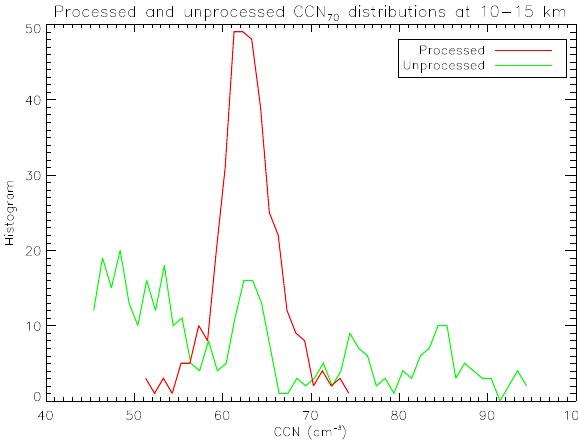
Fig. 5. Time series of surface-level N 10 . In both parts of each plot, the solid horizontal line shows the mean of all 360 measurements. Blue diamonds represent unperturbed values, and red diamonds rep- resent perturbed values. (a) The dashed horizontal lines show the uncertainty on the mean, as given in Eq. (7). The diamonds show the daily means, and the error bars show the 95% confidence in- terval of the distribution between the months on that day, as given in Eq. (6). The ensemble mean is always within the 95% CI for both perturbed and unperturbed runs. (b) The dashed horizontal lines show the 95% confidence internal of the ensemble, and the diamonds show each of the individual measurements on that day. The perturbed data are no more likely to fall outside this limit than the unperturbed data.